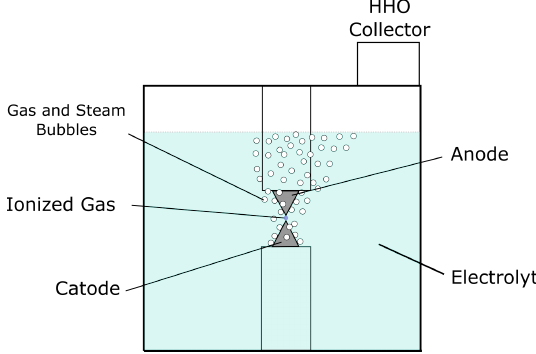
Figure 4. Pulsed plasmolysis cell diagram (front view).